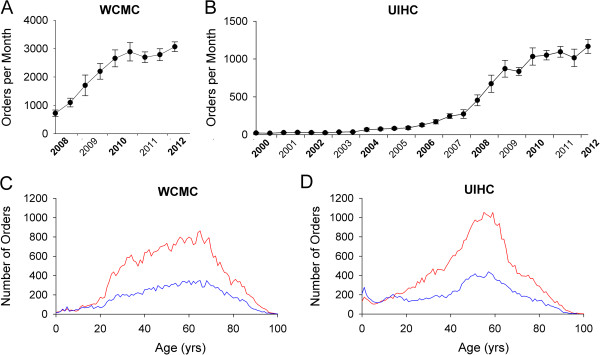
25(OH)D immunoassay - orders by institution, age, and sex. A, B. Average number of 25(OH)D orders per month (in six month bins) at WCMC (A) and UIHC (B). Error bars are ± SD. C,D. Total number of orders by patient age and sex (female = red lines; male = blue lines) at WCMC (C; 20 months analyzed) and UIHC (D; 153 months analyzed). Data are binned to 1 yr age intervals.